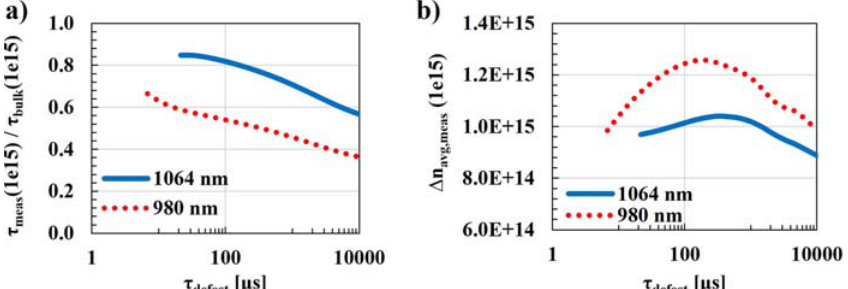
Fig. 4. The accuracy of the measured lifetime (a) and injection level (b) at 10 15 cm (cid:1) 3 excess carrier density is much better using the 1064 nm laser. N dop =10 16 cm (cid:1) 3 , S front =10 6 cm/s, F =2 (cid:3) 10 19 cm (cid:1) 2 s (cid:1) 1 .